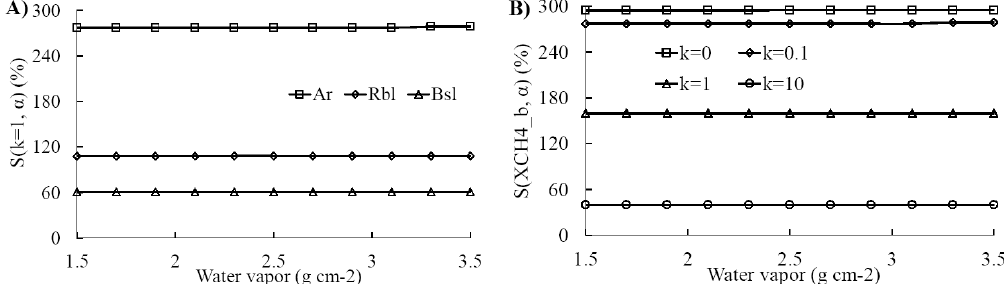
Figure A4. S (XCH 4_b , α ) resulted from an underestimation of 0.02 in (cid:36) s for A ) three pixels Asphalt road (Ar), Brown sandy loam (Bsl), and Reddish brown sandy loam (Rbl) with the XCH 4 plume case of k = 0.1, and B ) pixel Ar with XCH 4 plume cases of k = 0, 0.1, 1,